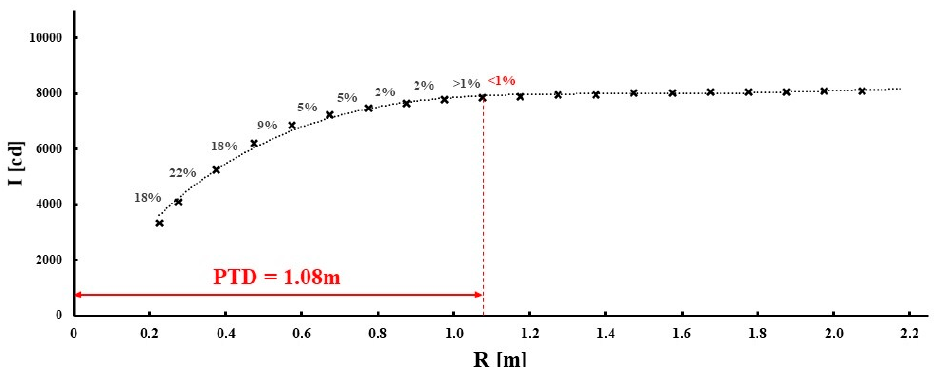
Figure 11. The method of the photometric test distance (PTD) determination based on the measure- ment results.